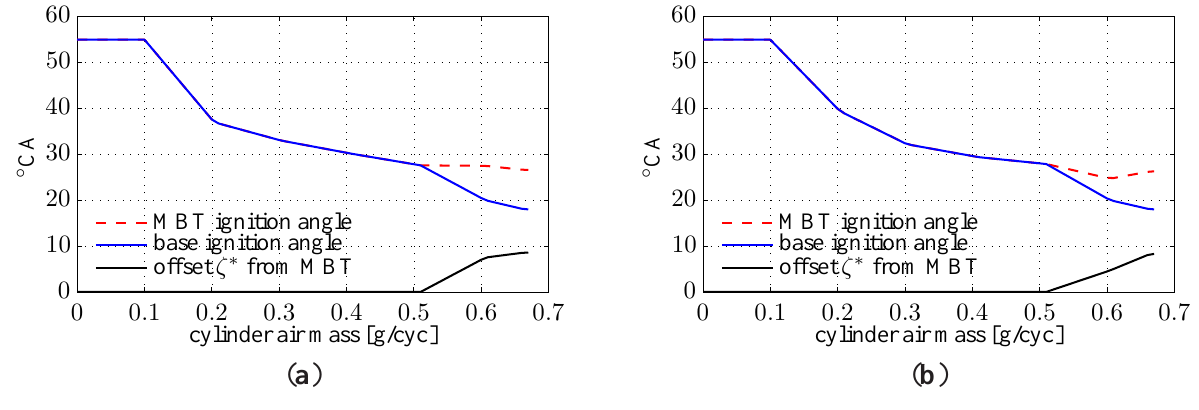
Figure 7. Ignition angles before top dead center and offset from MBT ignition angles at 2000 rpm. ( a ) cylinder 1; ( b ) cylinder